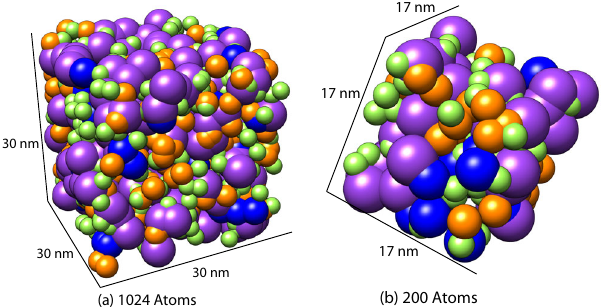
Fig. 1 Comparison of simulation sizes used in Machine Learning and DFT calculations. Each ion type is represented by a color — Fluorine in green, Sodium in blue, Potassium in pink, and Lithium in orange. a Simulation size used with a Machine Learning Potential with a total simulation size of 1024 atoms and a side length of 30 nm. b Simulation size used with DFT calculations with a total simulation size of 200 atoms and a side length of 17 nm.